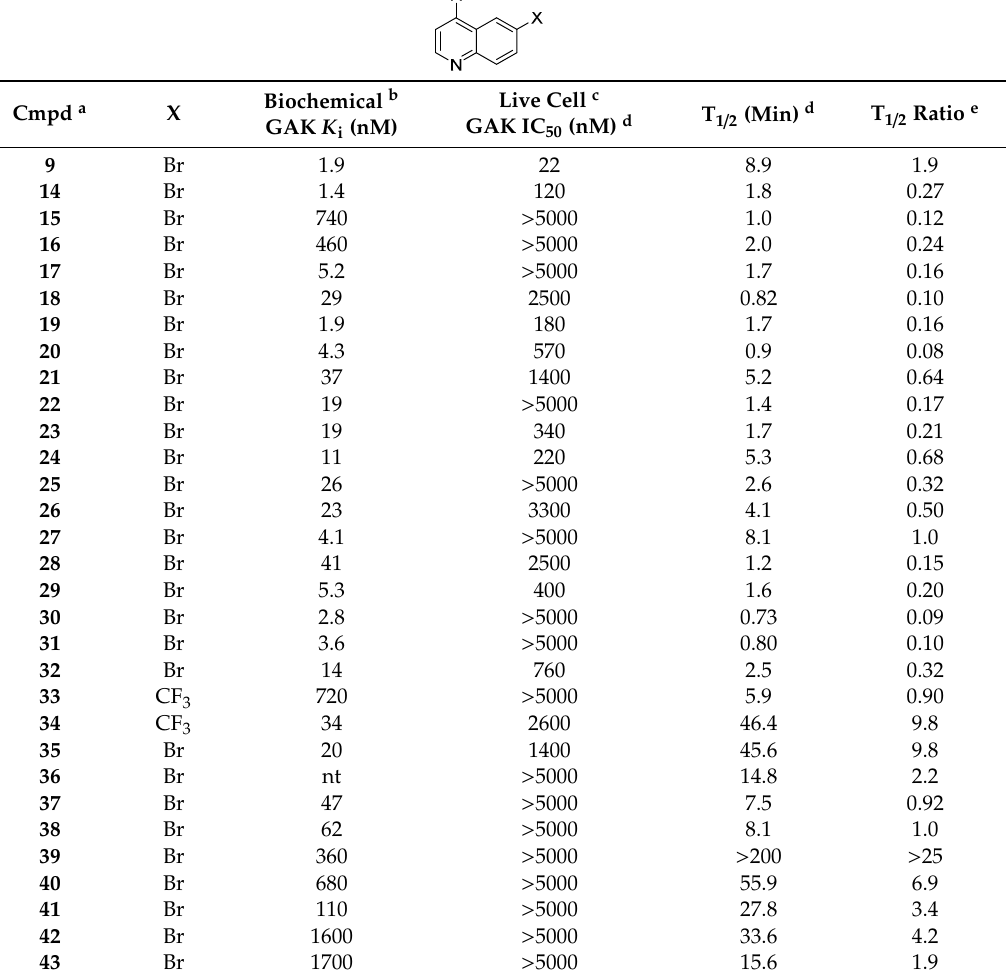
Table 3. GAK affinity measurements and microsomal clearance of isosteric replacements of 9 Table 3. GAK a ffi nity measurements and microsomal clearance of isosteric replacements of 9 .